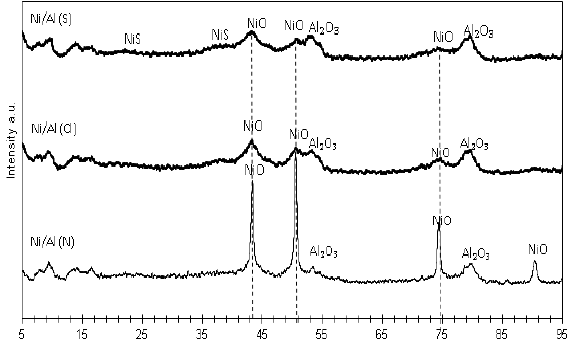
Fig. 1. X-ray diffractograms of the obtained catalysts of Ni/Al (N), Ni/Al (S) and Ni/Al (Cl)